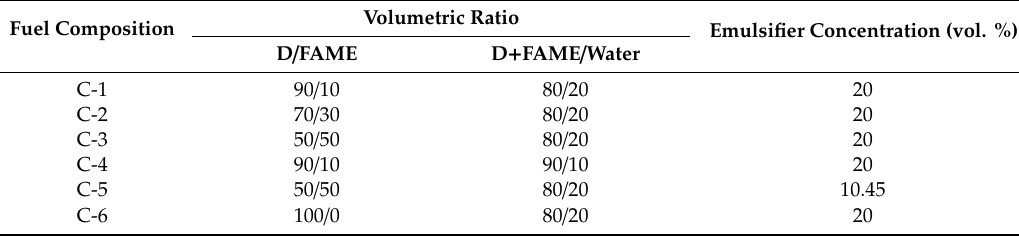
Table 4. Component composition of the fuel under study.